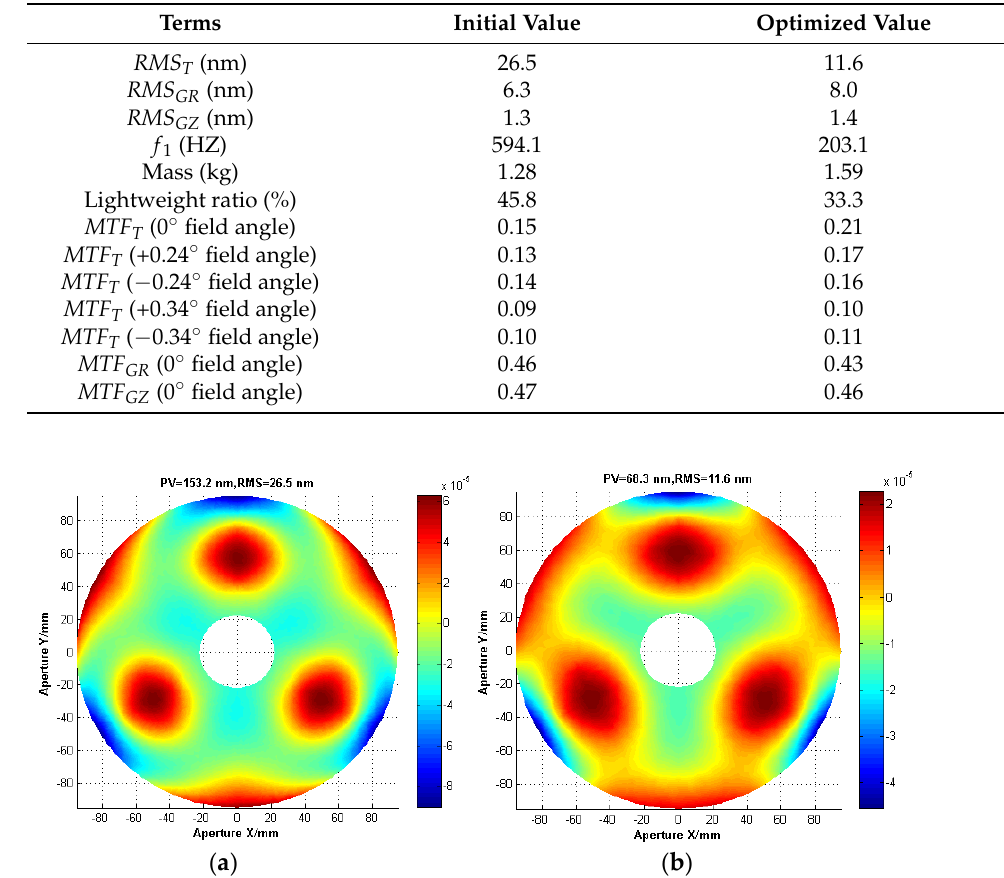
Figure 7. Iterative history of the mirror surface shape error. Table 4. Comparison of initial and optimal primary mirror component design. Table 4. Comparison of initial and optimal primary mirror component design.